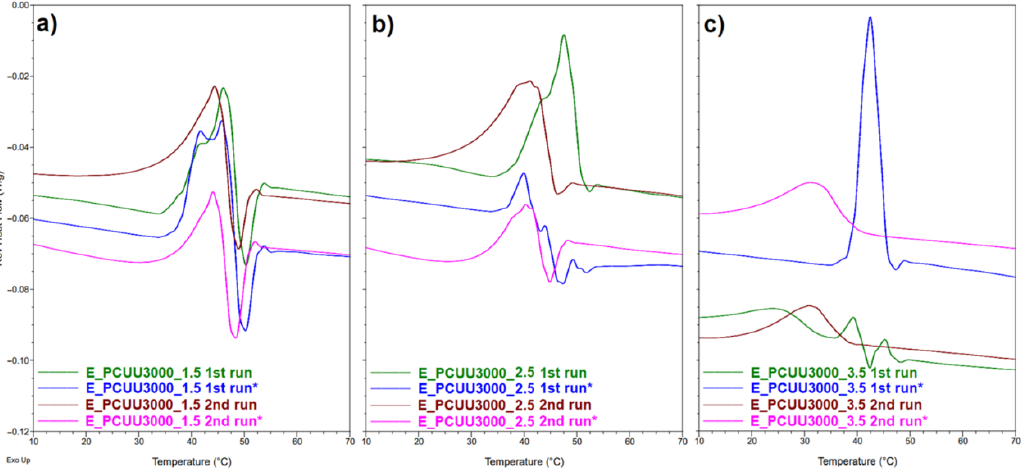
Figure 10. Reversible heat flow curves based on MDSC measurements of ( a ) E_PCUU3000_1.5; ( b ) E_PCUU3000_2.5; and ( c ) E_PCUU_3.5. The * symbol refers to sample elongated with 100% strain (1st run *) and the second heating run of the previously elongated sample after its return to the primary shape (2nd run *).